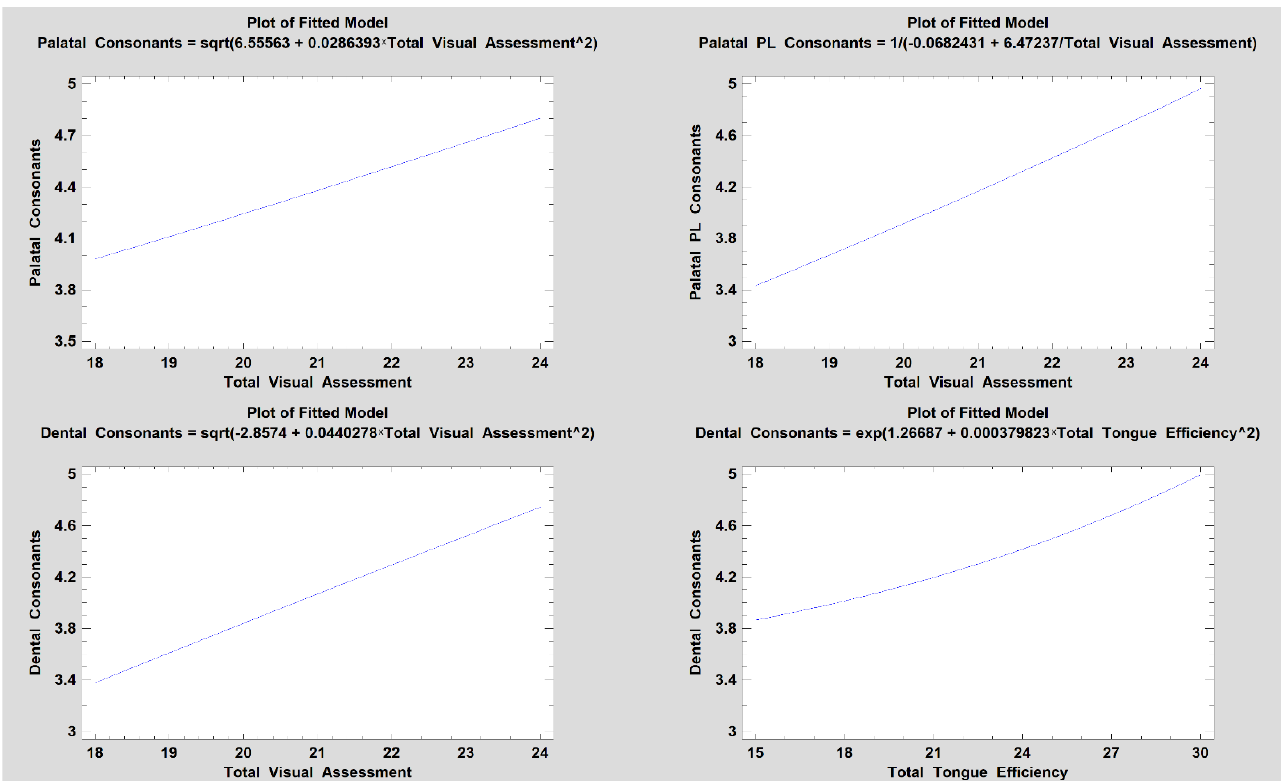
Figure 1. Final palatal, palatal_pl, and dental consonant articulation was related to the postoperational Total Visual Assessment ( p < 0.05). Such a relationship was also observed between dental consonants and total Tongue Efficiency assessed postoperatively ( p < 0.05).